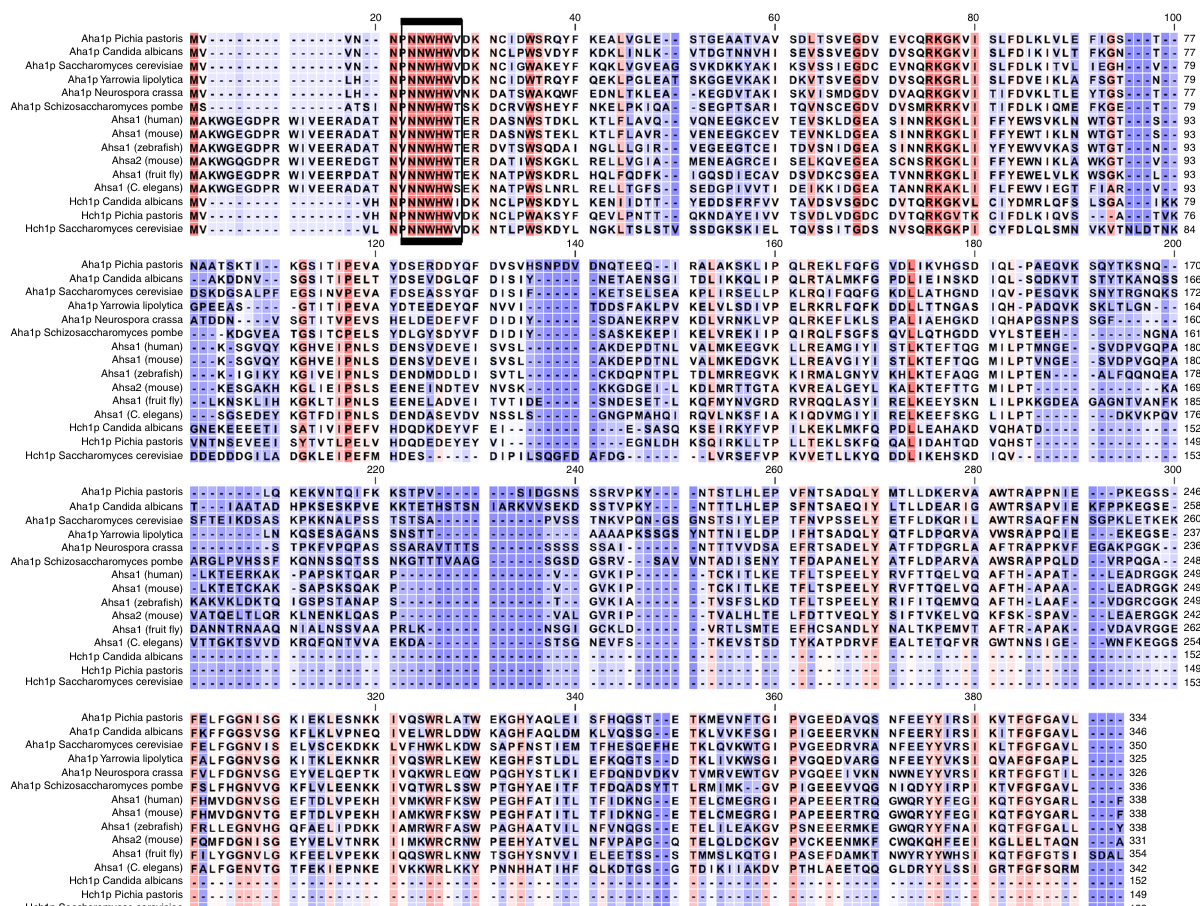
Fig. 1 Alignment of Aha-type co-chaperones. Alignment of Aha1p and Hch1p homologs shows that the NxNNWHW motif is strongly conserved across